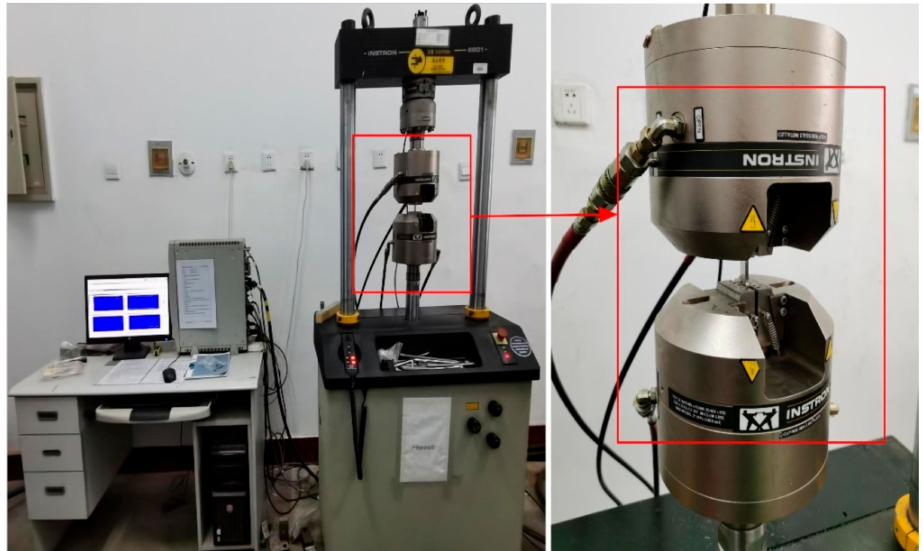
Figure 4. Fatigue test